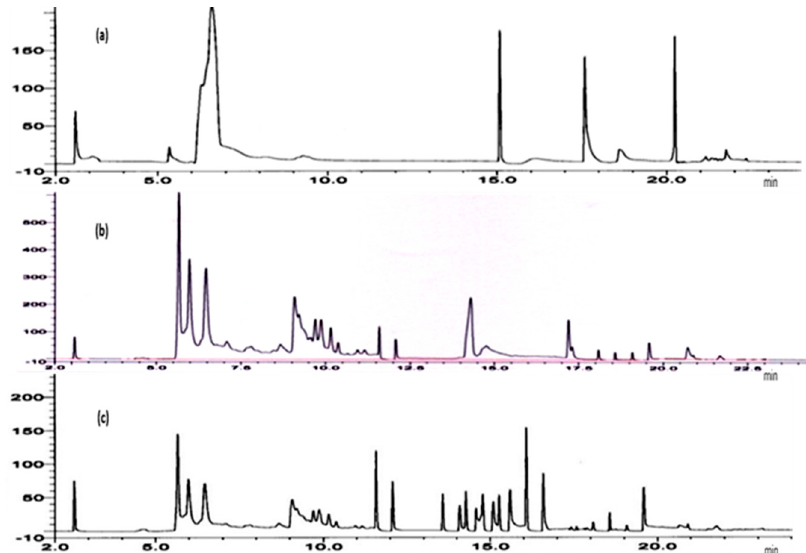
Figure 1. Chromatographic fingerprints of E. longifolia roots. ( a ) 0–6.0 min: 80% A:20% C; 6.0–16.0 min: